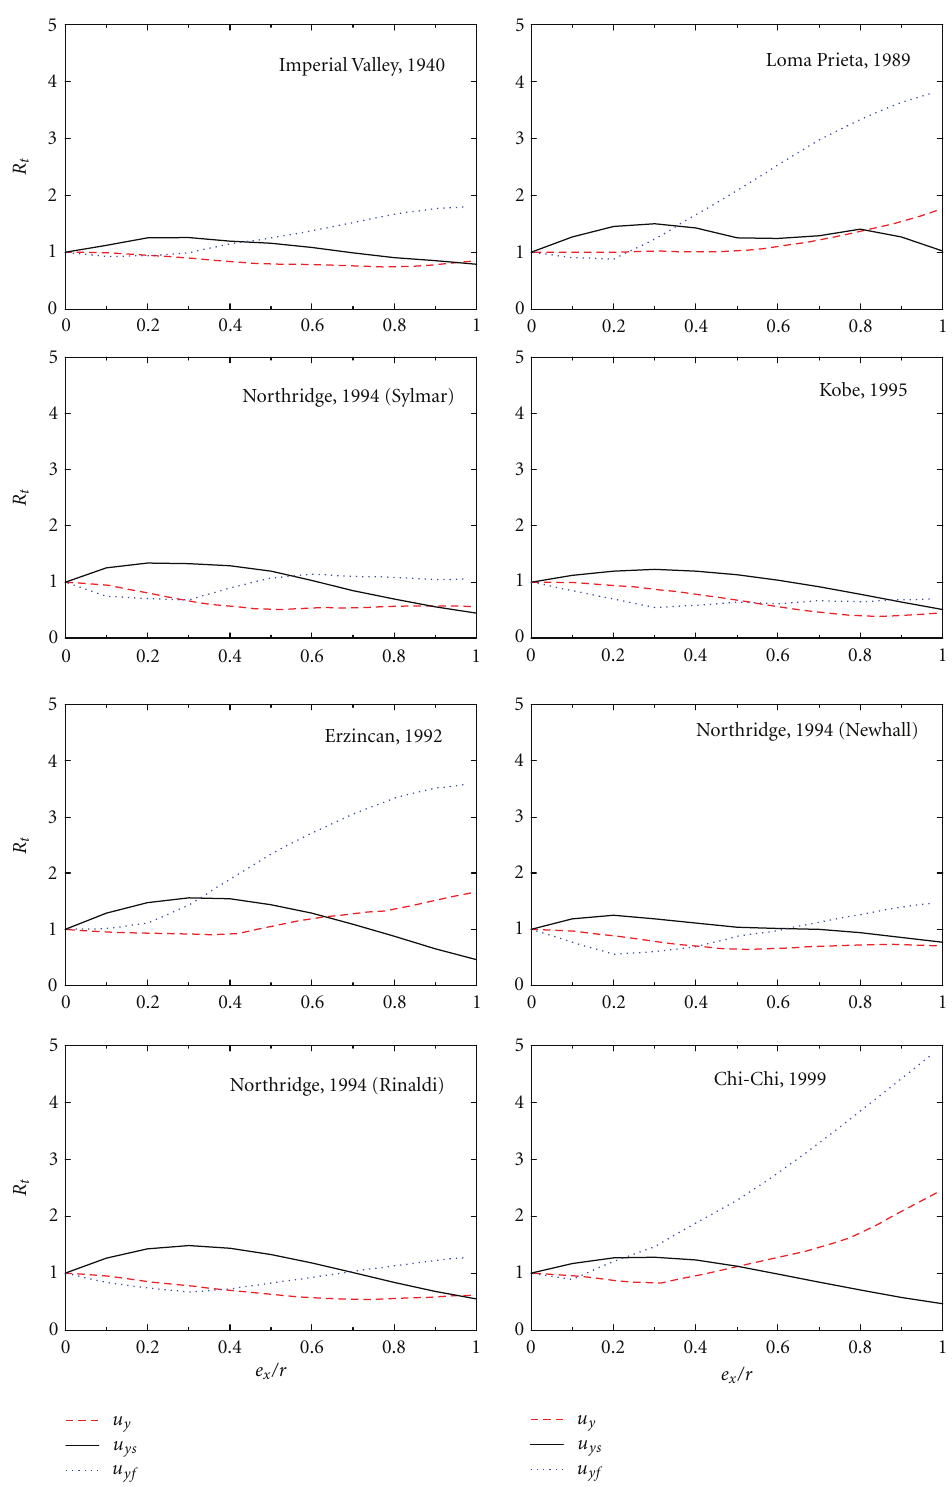
Figure 10: E ff ect of eccentricity on response ratio, R t for various peak displacements ( T y = 1s, Ω θ = 0 .